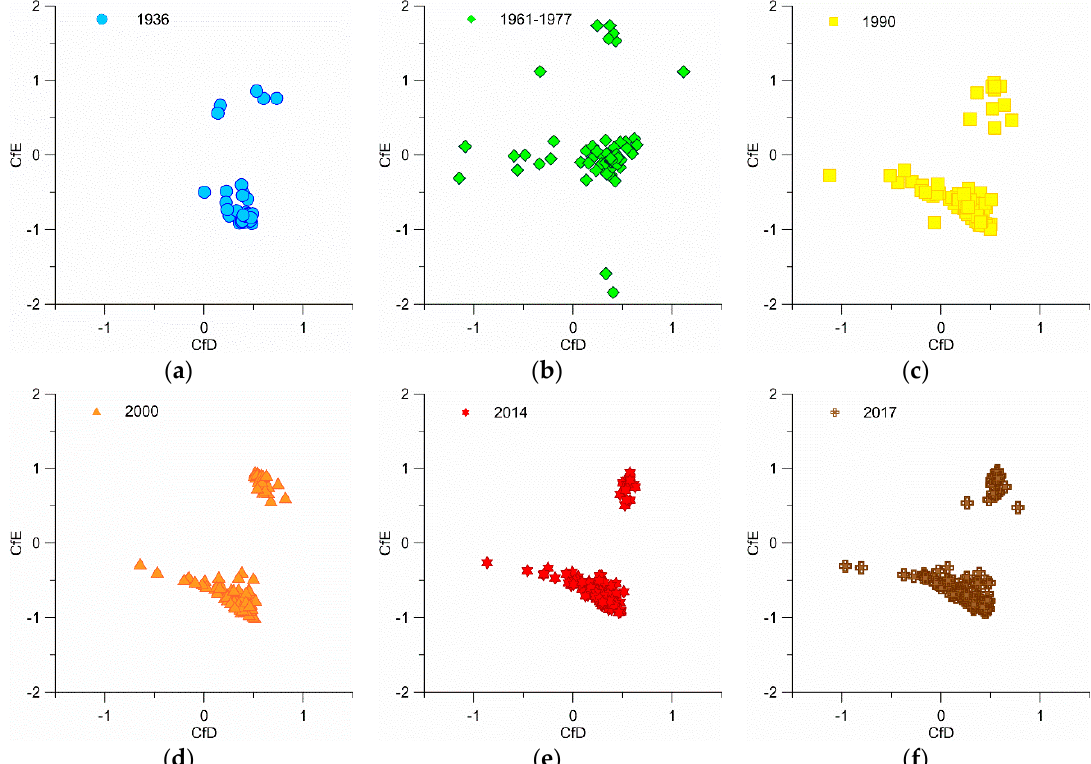
Figure 3. Relationships between the glacier front dynamics indicator CfD and the ice-cliff balance indicator CfE for Spitsbergen tidewater glaciers in selected years of the 1936–2017 period: ( a ) 1936; ( b ) 1961–1977; ( c ) 1990; ( d ) 2000; ( e ) 2014; and ( f ) 2017.